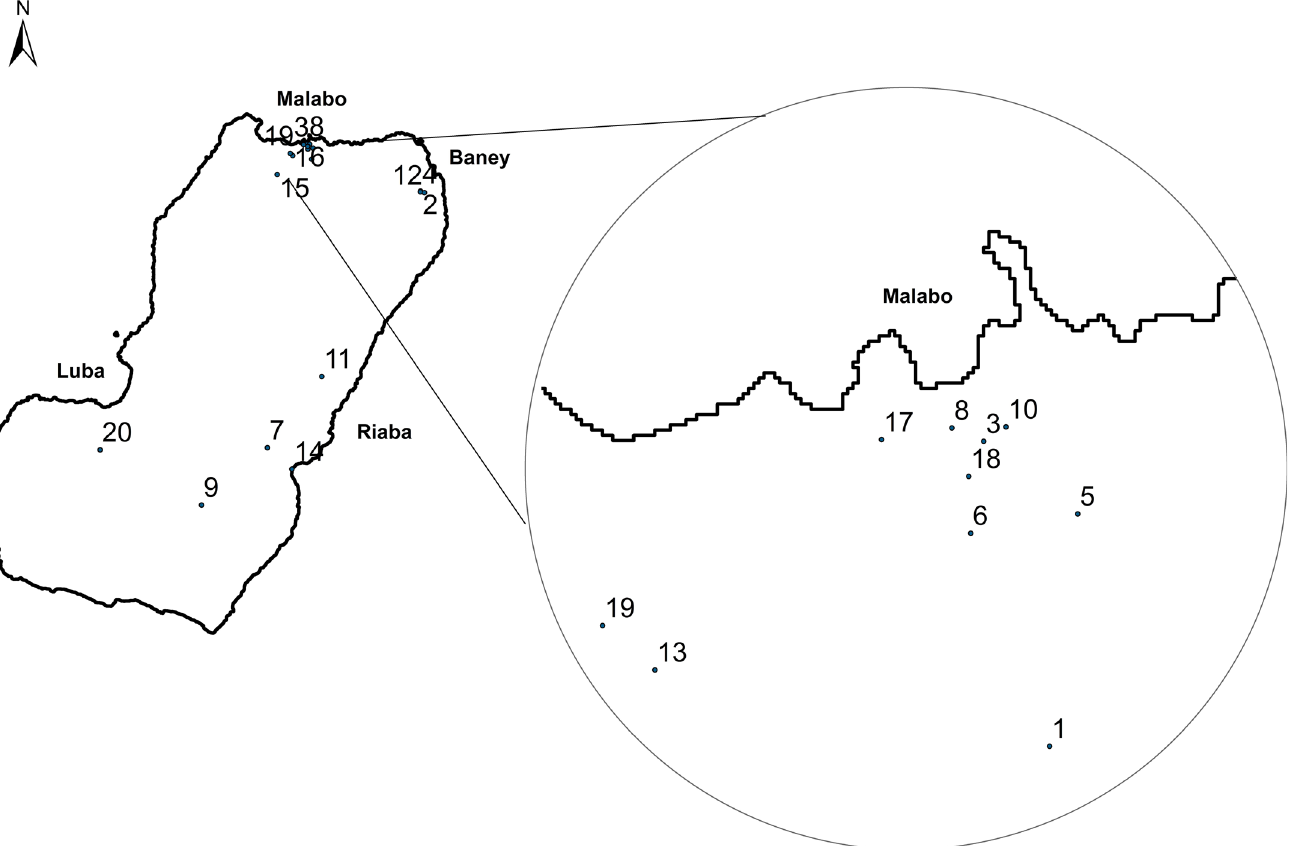
Fig 1. House-holds distribution in the study area, Bioko Island, Equatorial